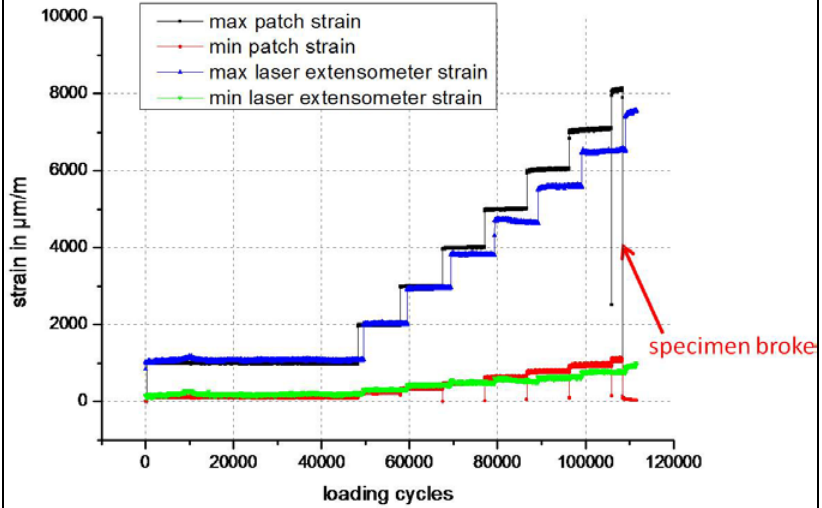
Figure 13. Strain response of a patch with embedded acrylate-coated FBG compared to the strain response of the laser extensometer for maximum and minimum